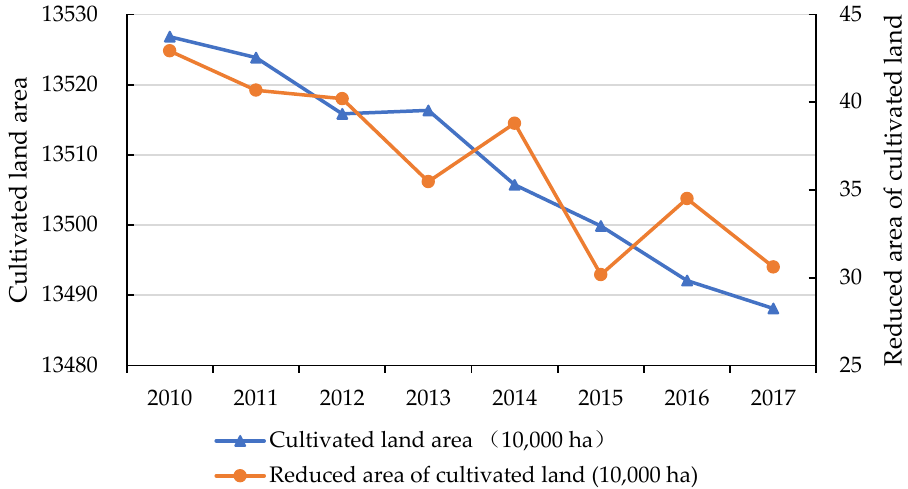
Figure 1. Cultivated land area and cultivated land area reduced in China.